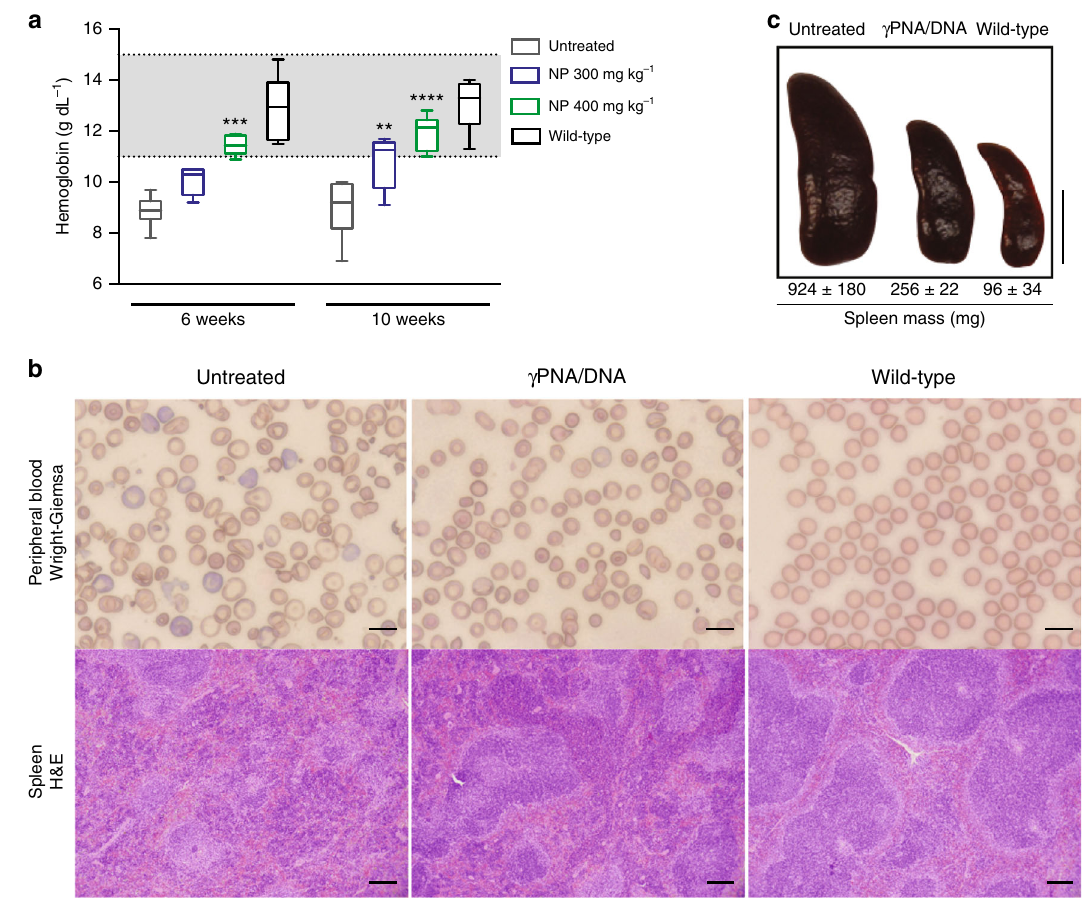
Fig. 3 E15.5 intravenous (IV) delivery of γ tcPNA/DNA nanoparticles (NPs) corrects anemia in thalassemic mice. a Blood hemoglobin levels of untreated Hbb th-4 /Hbb + mice, Hbb th-4 /Hbb + mice treated with γ tcPNA/DNA NPs at E15.5, and wild-type B6 mice, wild-type hemoglobin range is denoted by the gray-shaded region between 11.0 – 15.1 g dl − 1 , ( n = 6 for all groups), horizontal lines within the boxes indicate the median, the box indicates the fi rst and third quartile, and the whiskers represent the range, statistical analysis by two-way ANOVA, ** P < 0.01, *** P < 0.001, **** P < 0.0001. b Wright – Giemsa stained blood smears of γ tcPNA/DNA NP treated mice 15 weeks post treatment compared to untreated Hbb th-4 /Hbb + and wild-type B6 mice (top) and H&E stained spleen sections from untreated Hbb th-4 /Hbb + mice, Hbb th-4 /Hbb + mice 15 weeks after E15.5 400 mg kg − 1 NP treatment and wild-type mice, ×4.2 magni fi cation (bottom). Peripheral blood scale bars = 10 μ m, spleen scale bars = 150 μ m. c Gross images of spleens from untreated Hbb th-4 /Hbb + mice, Hbb th-4 /Hbb + mice 15 – 30 weeks after E15.5 400 mg kg -1 NP treatment and wild-type mice. The spleen mass ± s.e.m. is reported for each treatment group, (untreated n = 7, γ PNA/DNA n = 3, wild-type n = 3). Scale bar (right) = 1